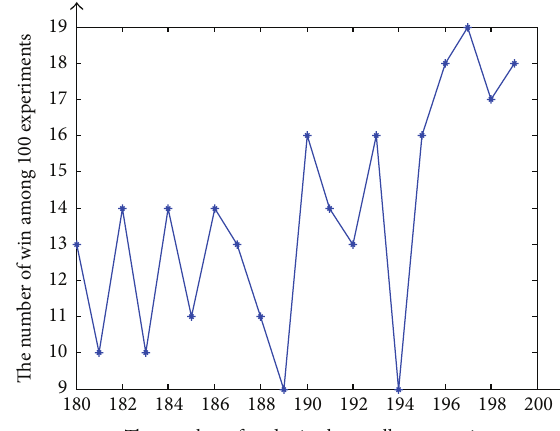
Figure 6: The Y-ray represents the number of win among 100 experiments. The X-ray represents the number of nodes in the small community. There is no noise in the